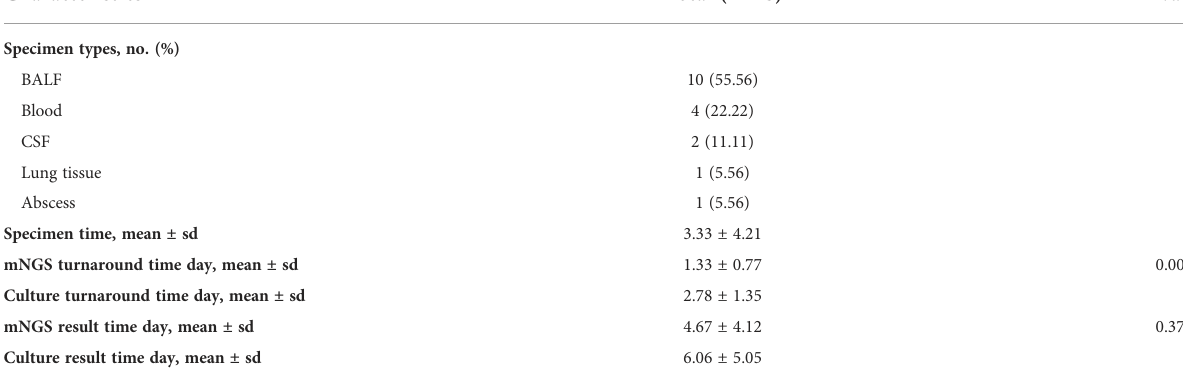
TABLE 2 mNGS and microbiological culture information.